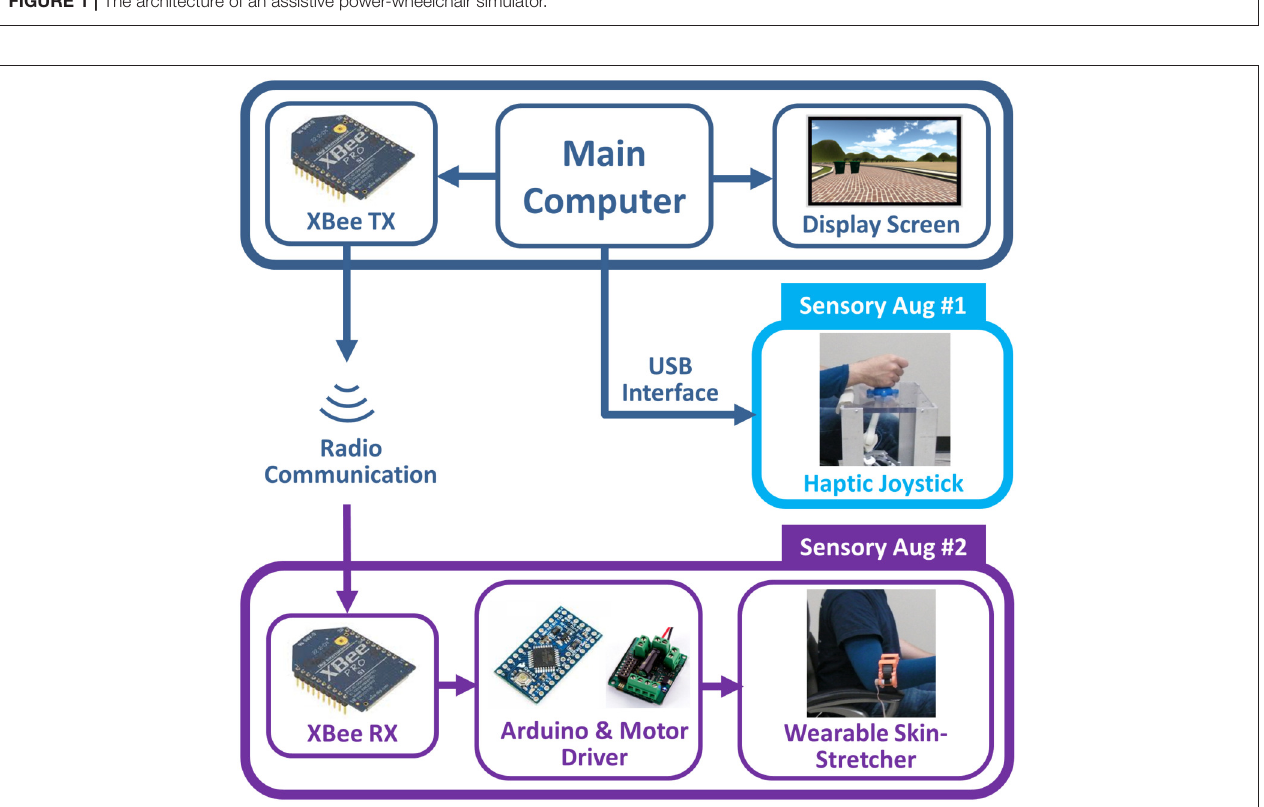
FIGURE 2 | Experimental system apparatus for human subject experiment: The augmented sensory feedback condition was corresponded to the two feedbacks via the haptic joystick or the wearable skin-stretcher.